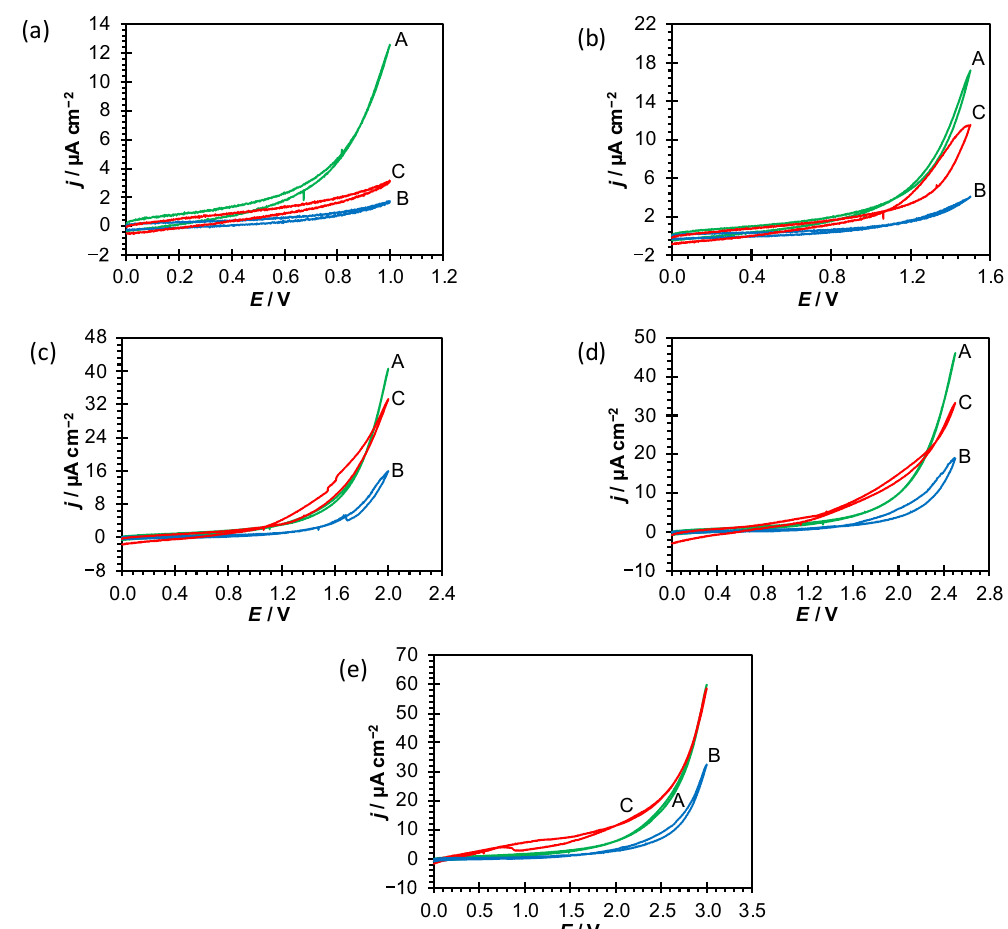
Figure 3. Cyclic voltammograms of the unmodified (Ti|TiO 2 —green lines(A)) and polyelectrolyte-modified Ti electrodes (Ti|TiO 2 |PDADMA—blue lines (B)) and Ti|TiO 2 |PSS—red lines (C)) recorded in 0.1 mol dm − 3 NaCl for various anodic limit potentials, E al , of 1.0 V ( a ), 1.5 V ( b ), 2.0 V ( c ), 2.5 V ( d ) and 3.0 V ( e ).